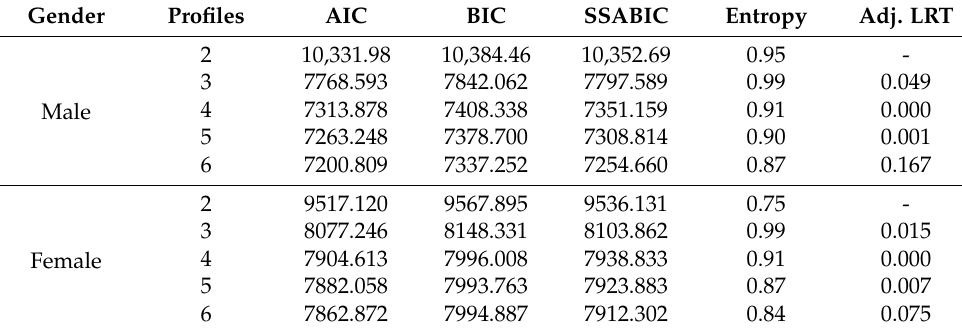
Table 1. Model fit information by the number of latent